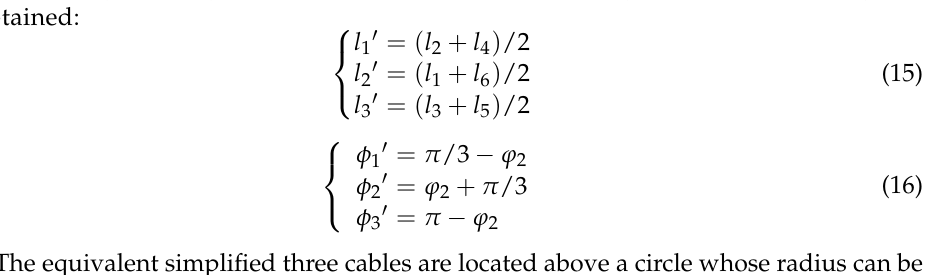
Figure 5. Equivalent diagram of the actuation cables at the proximal segment.